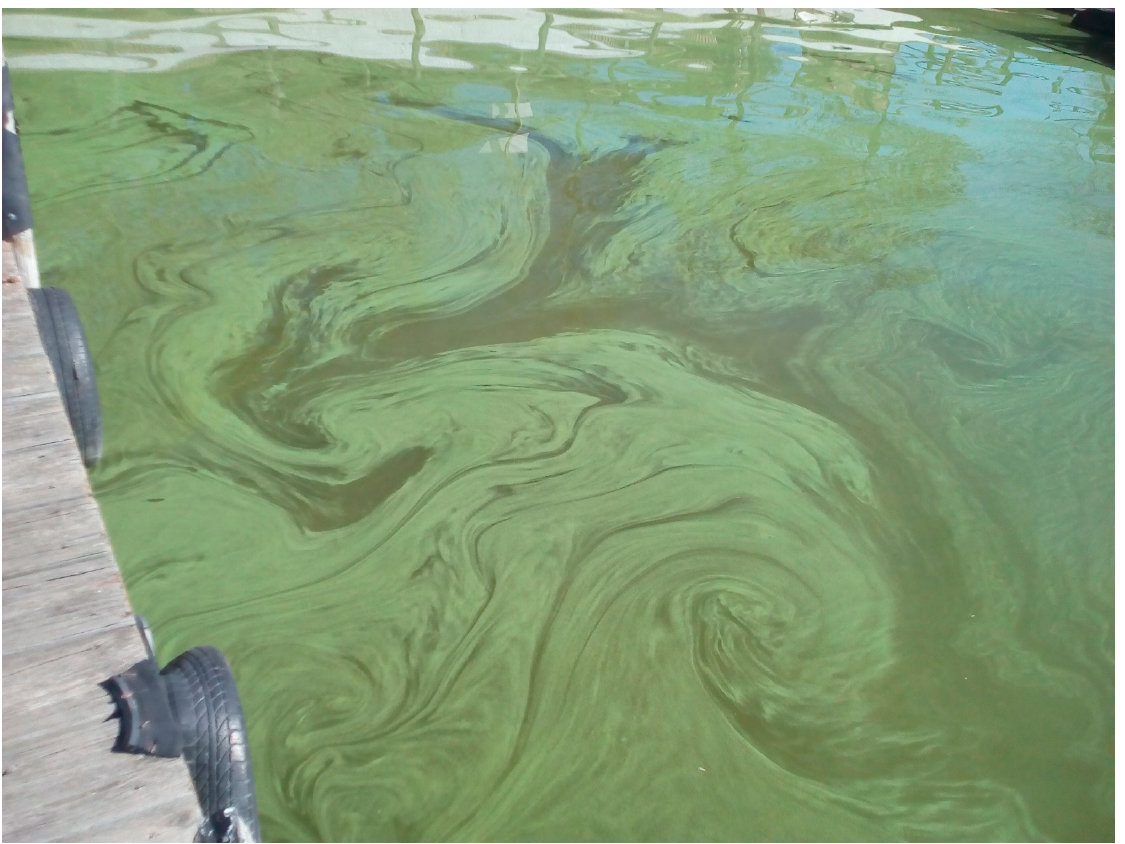
Figure A3. Cyanobacteria bloom in Albufera of Valencia. Floating colonies accumulate in some places by breeze effect. Date: 7 November 2016. Source: J.S.